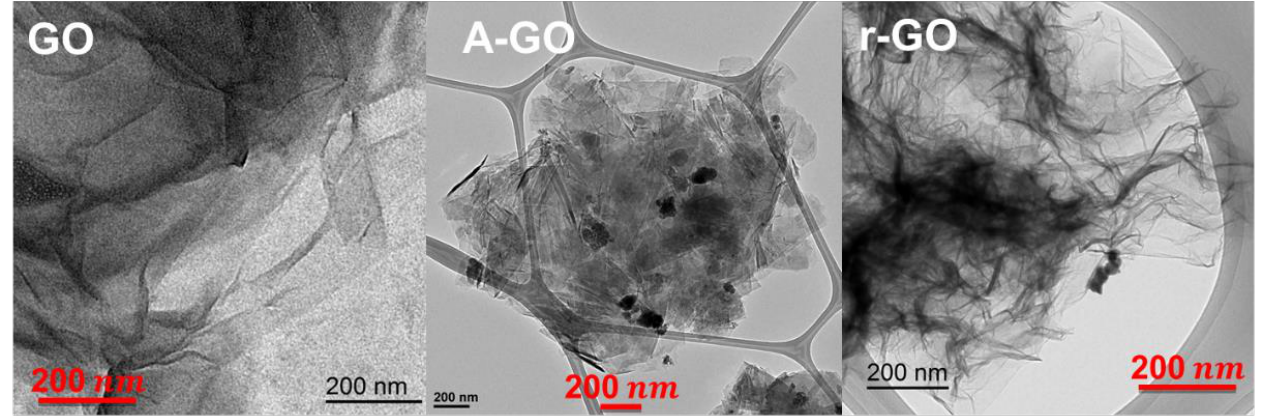
Figure 7. TEM micrographs of the graphene oxide derivatives on carbon grid. In summary, the GO derivatives differ in surface chemistry and morphology. The GO surface contains the highest amount of oxygen functional groups, mainly C-O groups, and both r-GO and A-GO surfaces have lower and similar amounts of oxygen functional groups, but the amount of nitrogen is somewhat higher in A-GO. Furthermore, GO has a fewer number of stacked graphene nano-sheets, r-GO depicts large ultrathin wave-like stacked graphene nano-sheets, and A-GO shows the most organized and stacked graphene nano-sheets. Therefore, different extent of interactions of those GO derivatives with the waterborne poly(urethane urea) can be